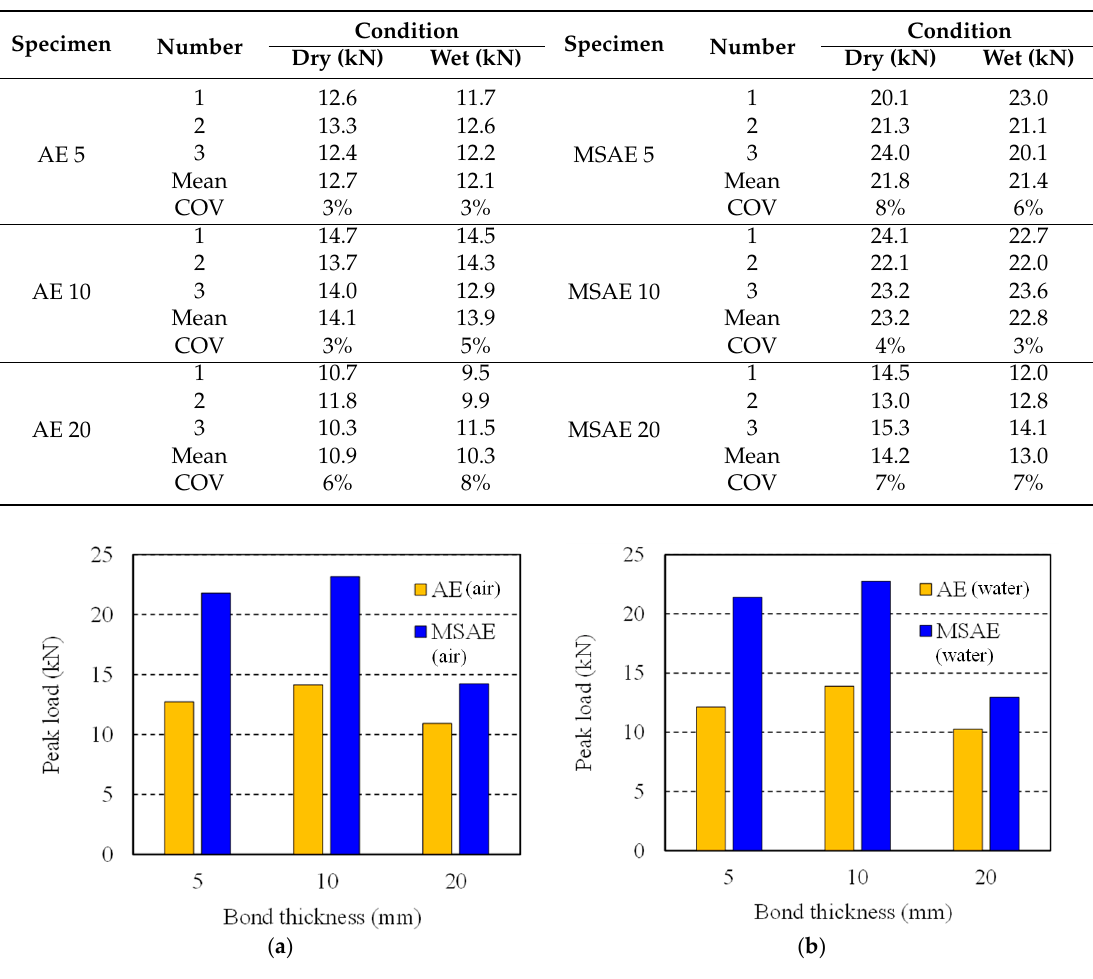
Figure 13. Peak loads for AE and MSAE specimens fabricated and cured in; ( a ) air; and ( b )